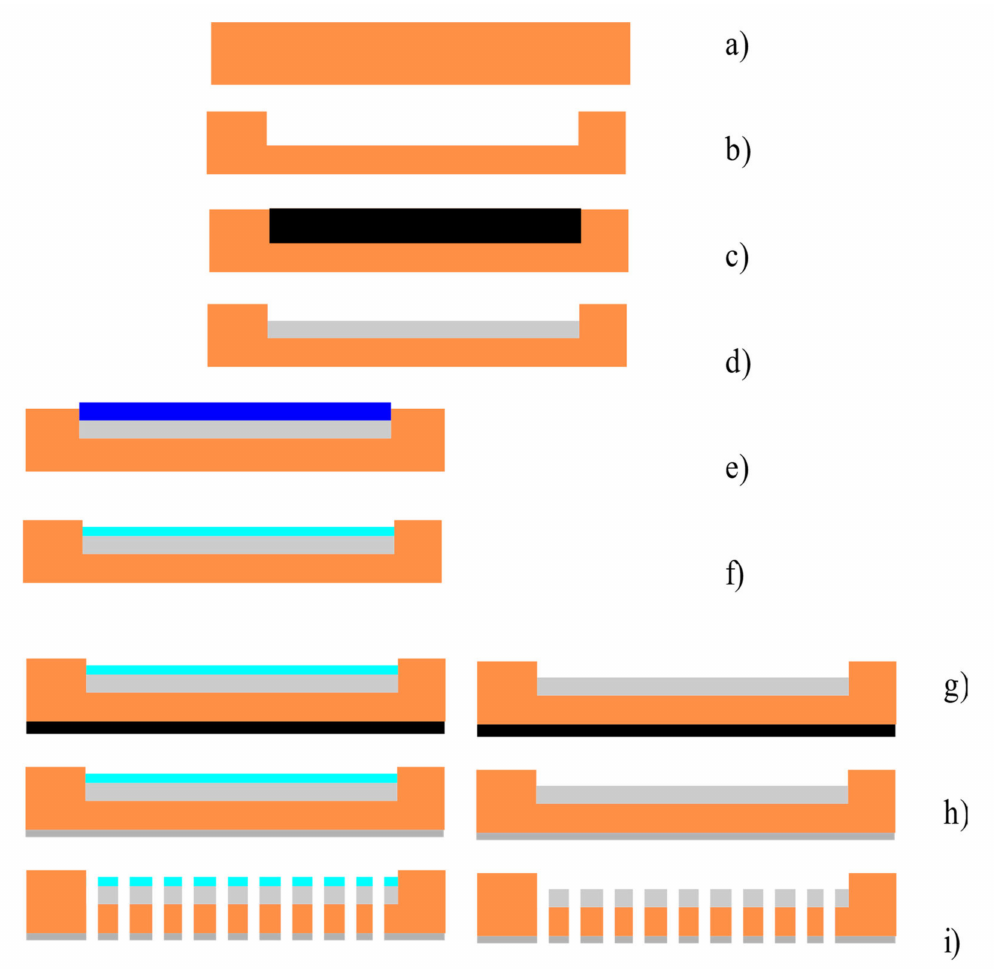
Figure 2. The diagram of the manufacturing process for the plates of the electrochemical cell contain- ing the electrodes. ( a ) Corundum substrate; ( b ) laser micro-milling bath for the platinum containing polymer pastes; ( c ) application of the platinum containing polymer paste; ( d ) annealing; ( e ) appli- cation of the non-conductive polymer paste; ( f ) annealing of the non-conductive polymer paste; ( g ) application of the platinum containing polymer paste on the opposite side of the corundum substrate; ( h ) annealing; ( i ) laser